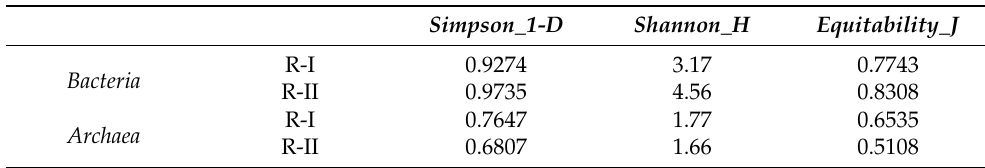
Table 3. Statistics analysis of the microbial 16 S rRNA gene libraries obtained from the high- throughput 16 S rRNA gene